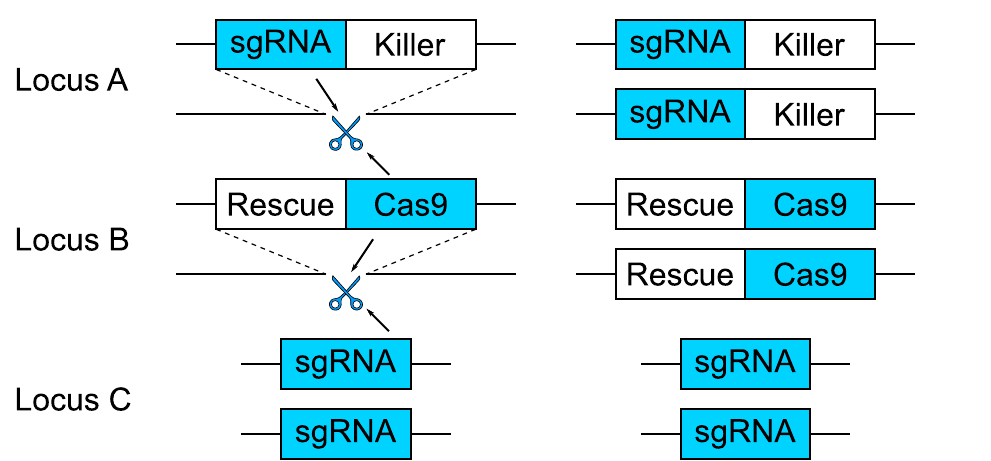
Figure 2. A schematic diagram of a daisy drive killer-rescue (DDKR) system. This is essentially SDKR but modified to include a third transgenic construct at an unlinked locus (C) that contains a sgRNA directing the Cas9 endonuclease to cut the wild-type sequence at locus